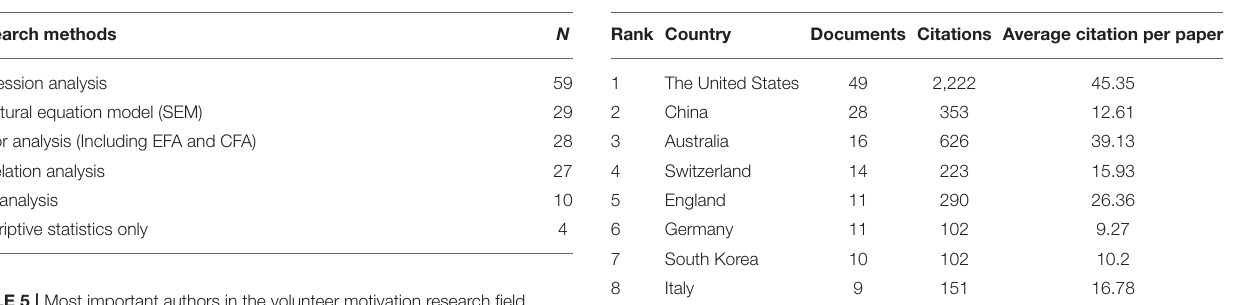
TABLE 4 | Research methods used in the study.